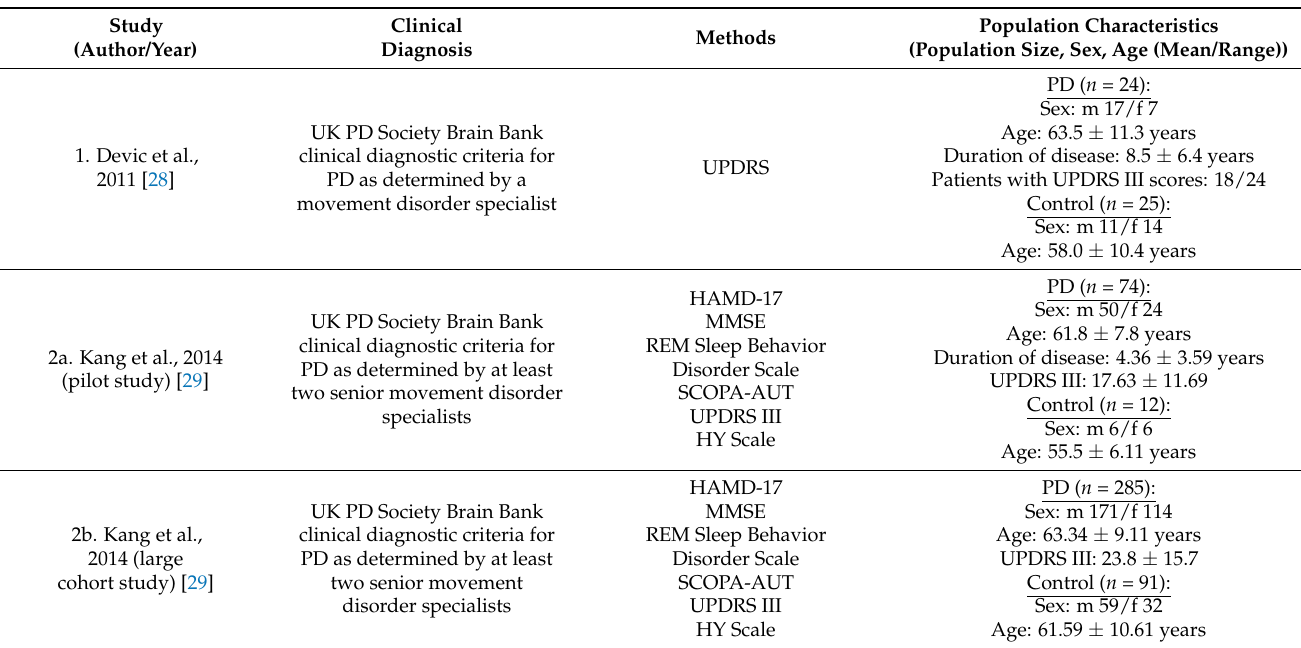
Table 3. Population characteristics in studies on salivary biomarkers for